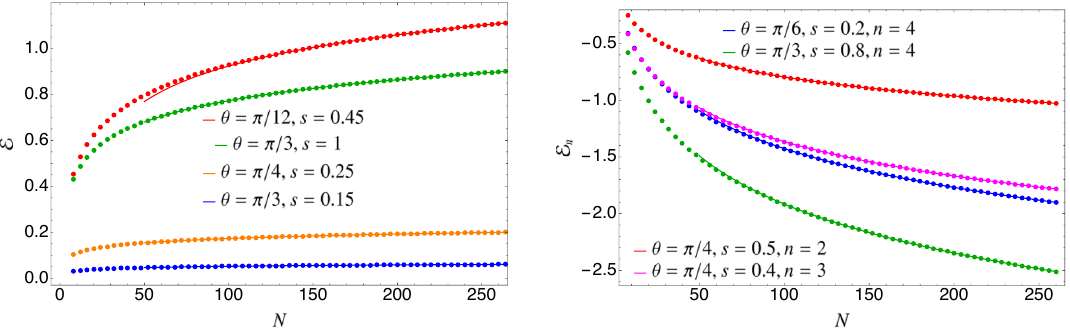
Figure 2 . The Rényi negativities E n in the three-wire junction for different values of s, θ and as a function of number of particles N . The lines show the curve C coefficients b are fitted using the data for N ≥ 80 . The prefactor C i